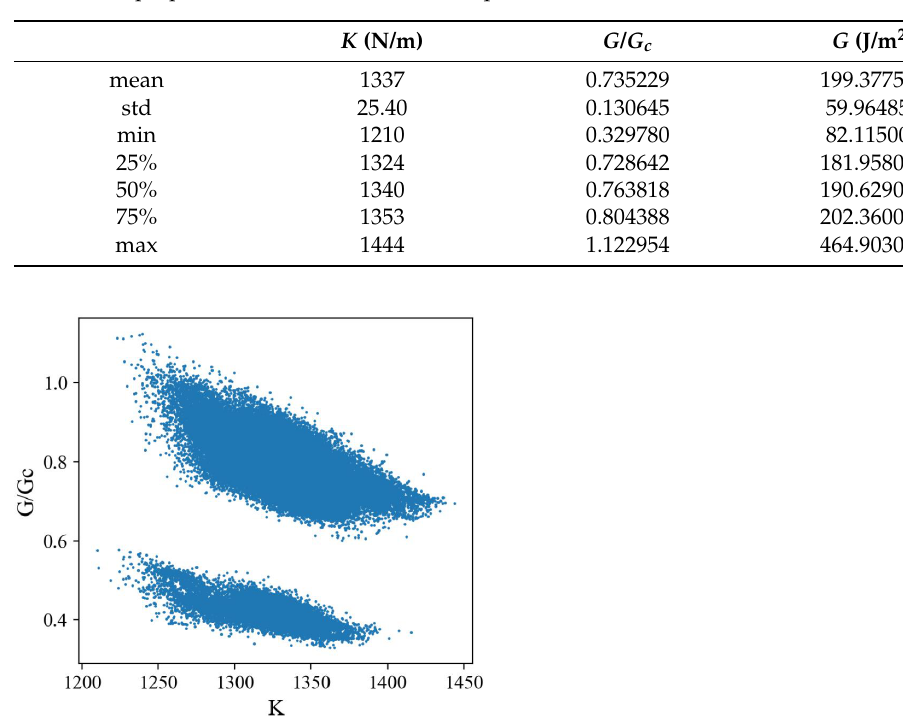
Table 1. Dataset analysis of 120,000 data generated from finite element method. 25%, 50%, and 75% indicate the properties’ first, second, and third quartiles.